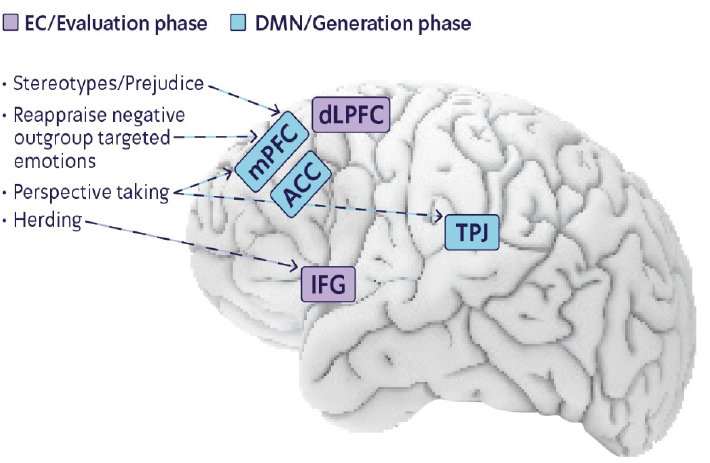
Figure 1. Common set of brain networks underlies both creativity and cognitive ‐ related biases. The generation phase (blue) comprises the mPFC, ACC, and TPJ, which also involve intergroup biases. The evaluation phase (purple) comprises the IFG, which also involves herding.